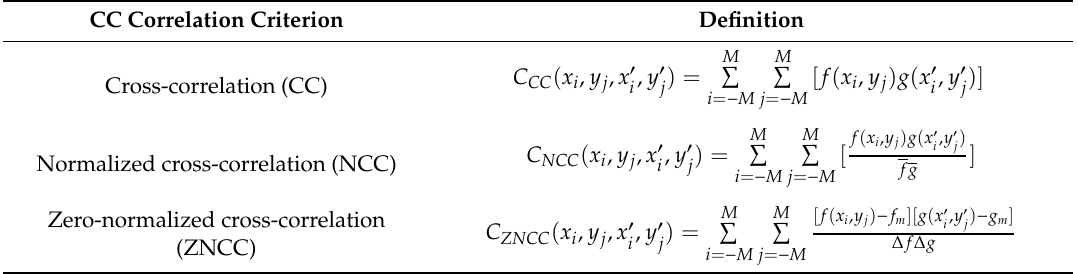
Table 1. Commonly used cross-correlation (CC) criteria and their definitions (M: natural number).